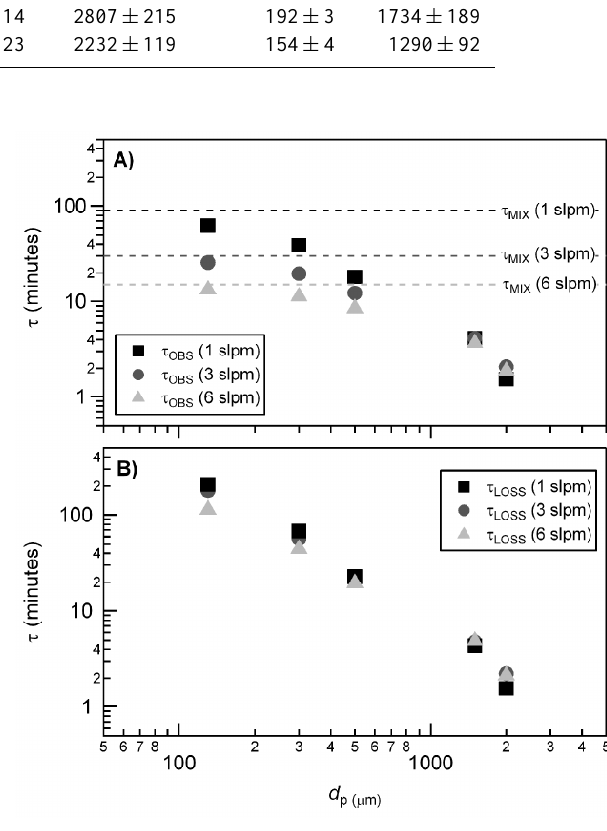
Fig. 7. (A) Observed lifetime as calculated from the decays shown in Fig. 6 as a function of particle size. For reference, the size inde- pendent lifetimes due to dilution alone are shown with dashed lines. (B) Calculated size dependent lifetime with respect to